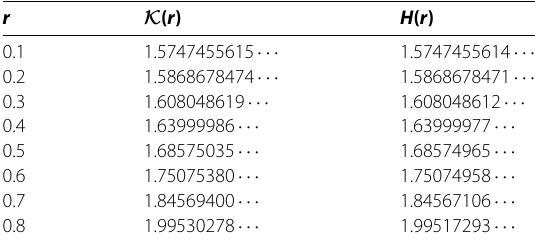
Table 1 Comparison of K ( r ) with H ( r ) for some r ∈ (0,1) r K ( r ) H ( r